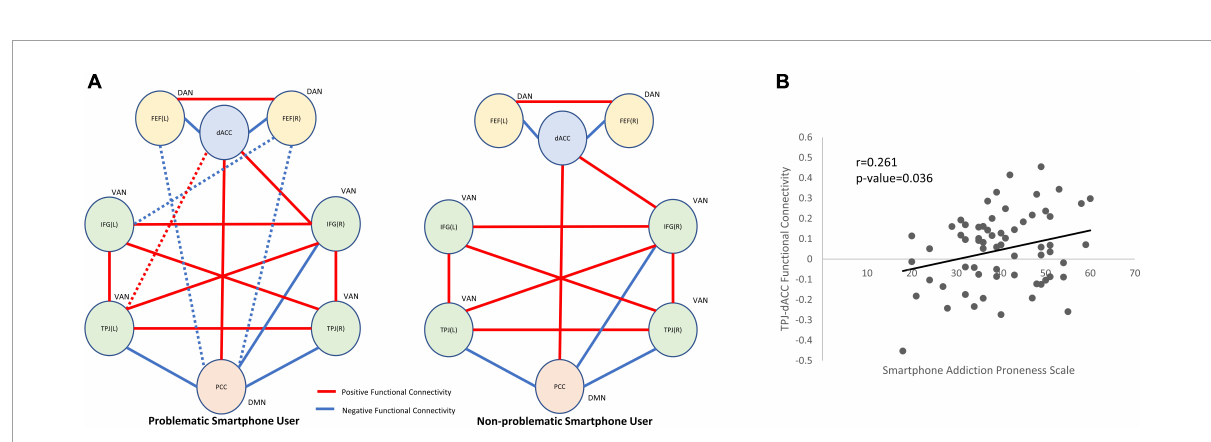
FIGURE2 Between-network connectivity and functional connectivity correlation with clinical variables. (A) Seed-to-seed within-group analysis (red line: positive functional connectivity; blue line: negative functional connectivity). The statistical inferences were thresholded using a p -value < 0.05. In problematic smartphone users, functional connectivity of dACC to left TPJ was identified which were not observed in non-problematic smartphone users. Functional connectivity of PCC to FEF was found in problematic smartphone user group, which were not observed in non-problematic smartphone user group. (B) Pearson correlation analysis for clinical correlation of functional connectivity. We identified positive correlation between TPJ-dACC functional connectivity and smartphone addiction proneness scale (Pearson’s r = 0.261, p -value = 0.036). DAN, dorsal attention network; VAN, ventral attention network; DMN, default mode network; dACC, dorsal anterior cingulate cortex; IFG, inferior frontal gyrus; TPJ, temporoparietal junction, PCC, posterior cingulate cortex; FEF, frontal eye